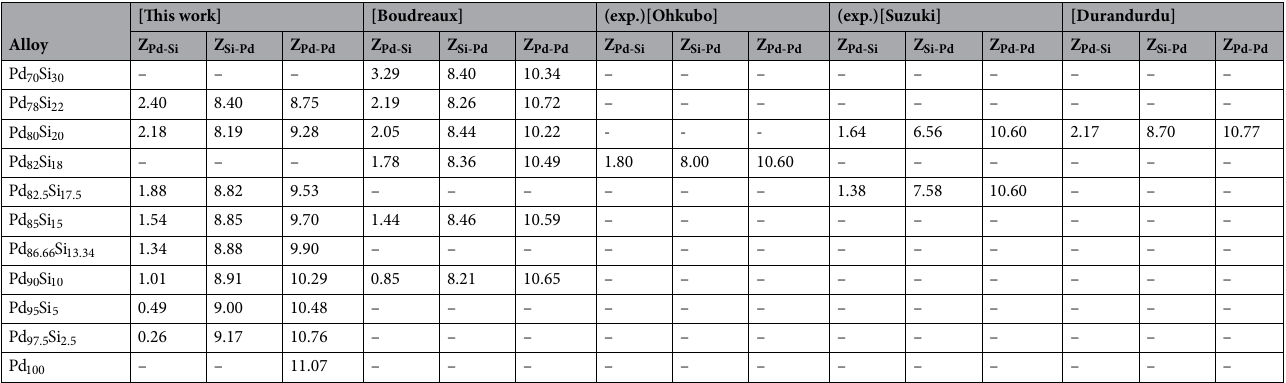
Table 4. Some coordination numbers (Z) for PdSi alloys, experimental 19,28,32 and simulational 32,33 , compared to our